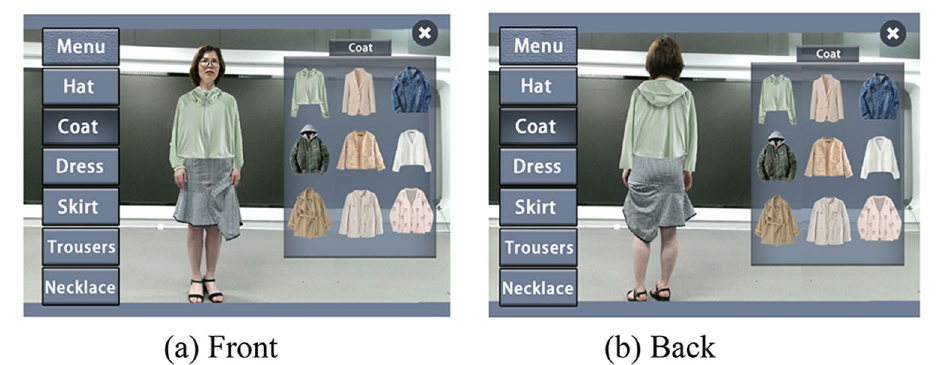
Figure 11. Virtual fitting effect of "Coat".